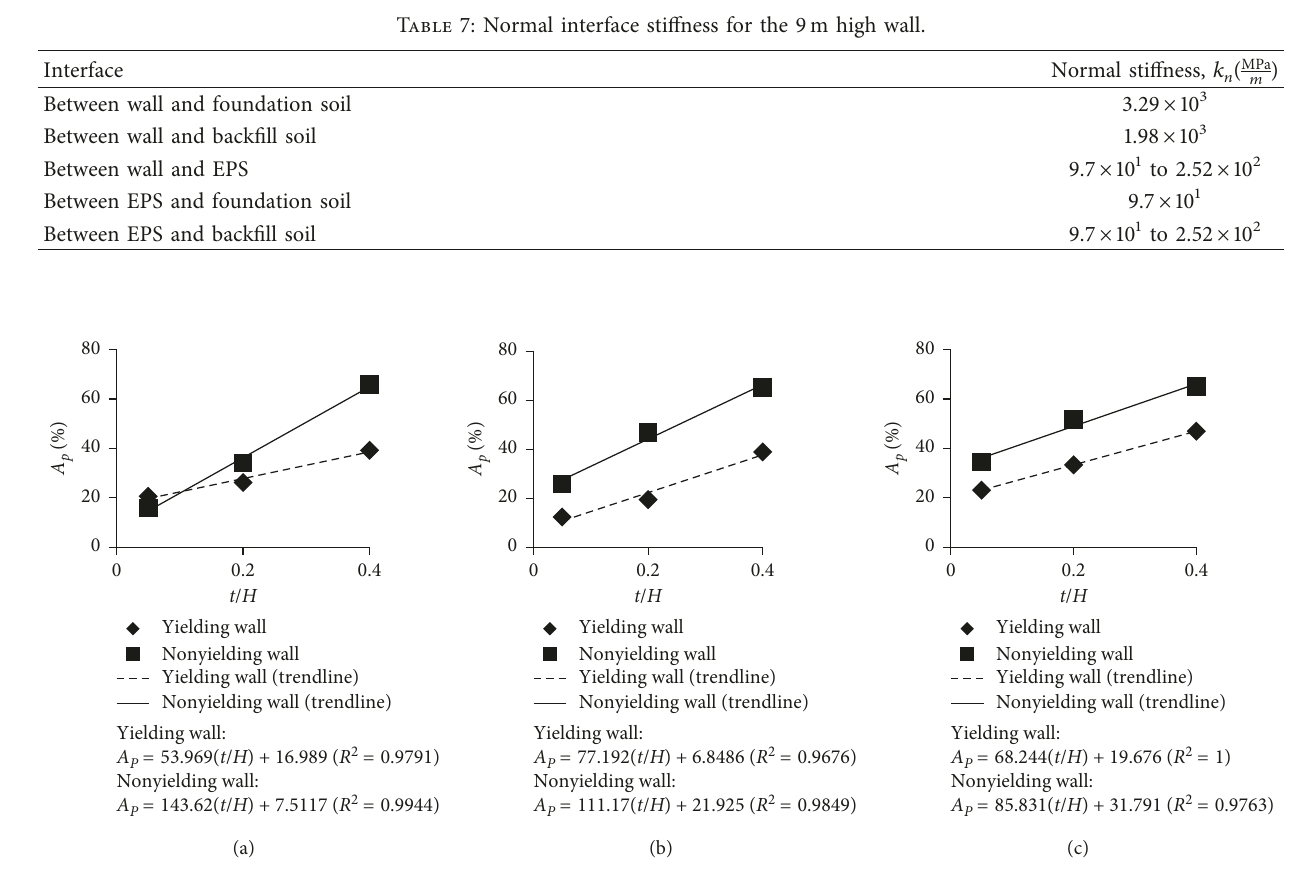
Figure 14: Influence of the EPS15 thickness ratio on reduction of lateral